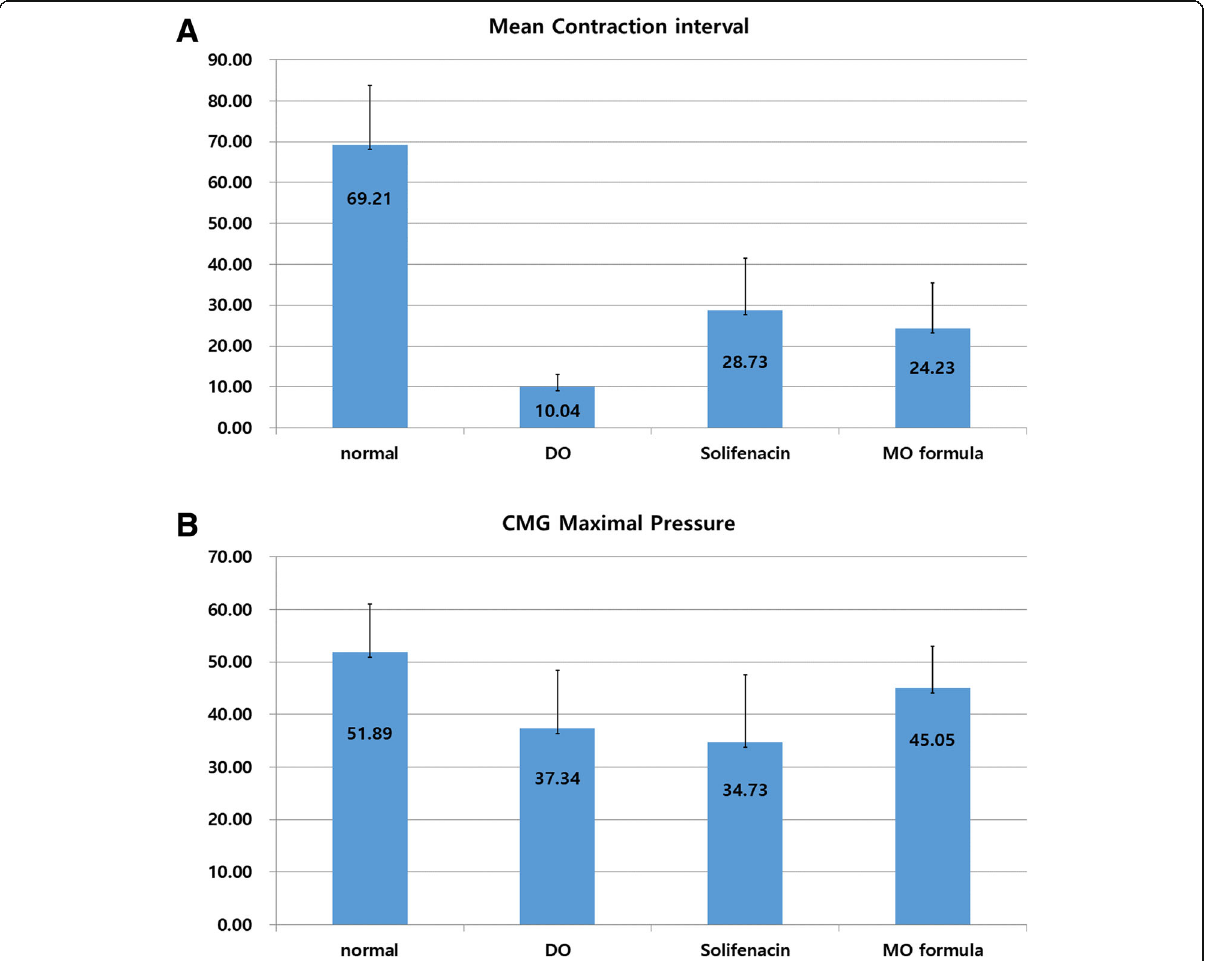
Fig. 2 Contraction feature of each group. a Mean contraction interval. Compared to normal group, DO, solifenacin, and MO formula show significant short contraction interval, but there is no statistical difference between solifenacin and MO formula. b Mean maximal pressure on CMG. In maximal pressure, the highest pressure in the normal group and the lowest pressure in the solifenacin